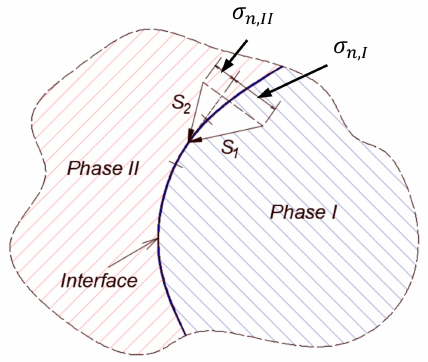
Figure 1. Surface forces at the two sides of the interface between two phases. Jump in the normal stress is correlated with the curvature of the interface. Tangential stress does not experience jump under the no-slip